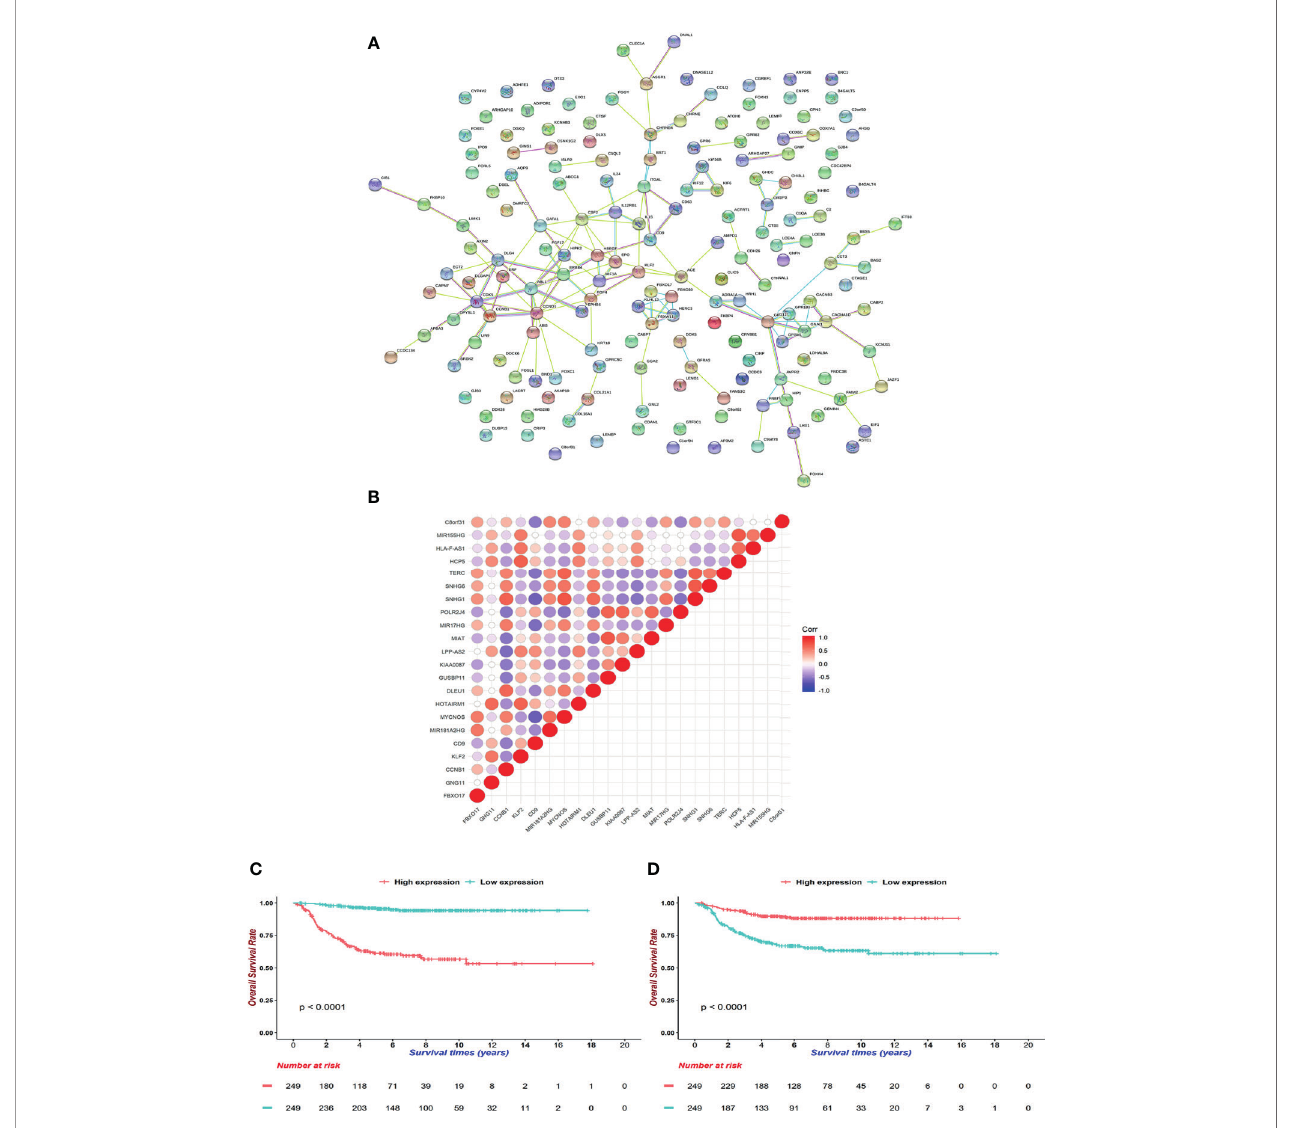
FIGURE 6 | Underlying hub genes and associated interactions in neuroblastoma. (A) The protein-protein-interaction (PPI) network was constructed by String website. (B) Mutual correlations among 18 hub genes fi ltered by cytoHubba module in Cytoscape software. The dots are colored red when Pearson correlation coef fi cients approach 1 and dots are colored blue when coef fi cients reach -1. (C, D) KM curves for CCNB1 and CD9 (D) . Expressions were cut by median levels. (both log-rank test p < 0.0001, n =